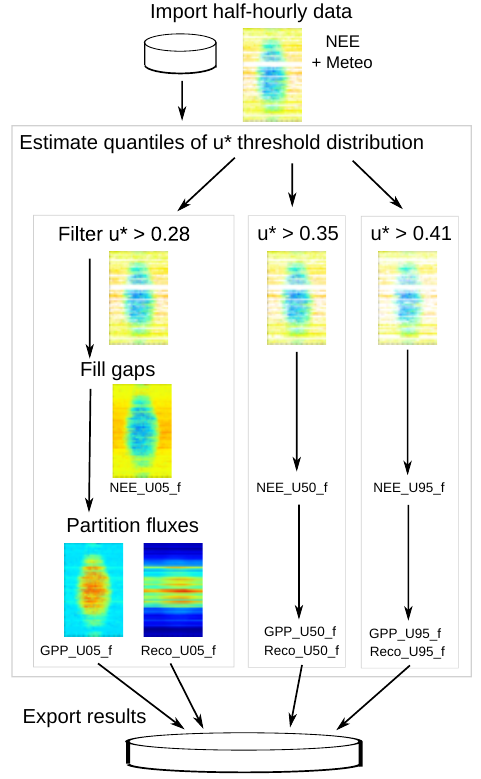
Figure 1. The workflow starts with importing the half-hourly (or hourly) data, in this example the year 1998 of the DE-Tha site. Next, a probability distribution of u ∗ threshold is estimated for each season. Gap filling and flux partitioning are performed for several quantiles of this distribution for an estimate of uncertainty. Finally the results are